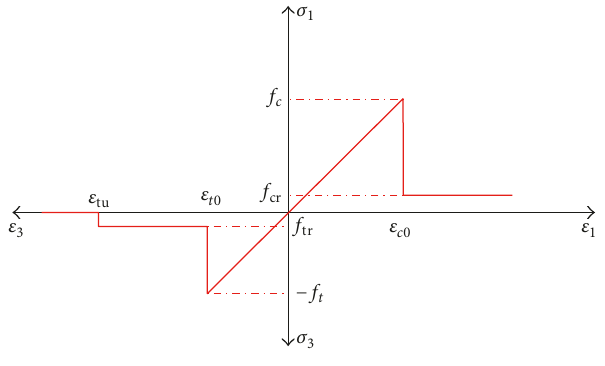
Figure 1: An example of constitutive damage law.